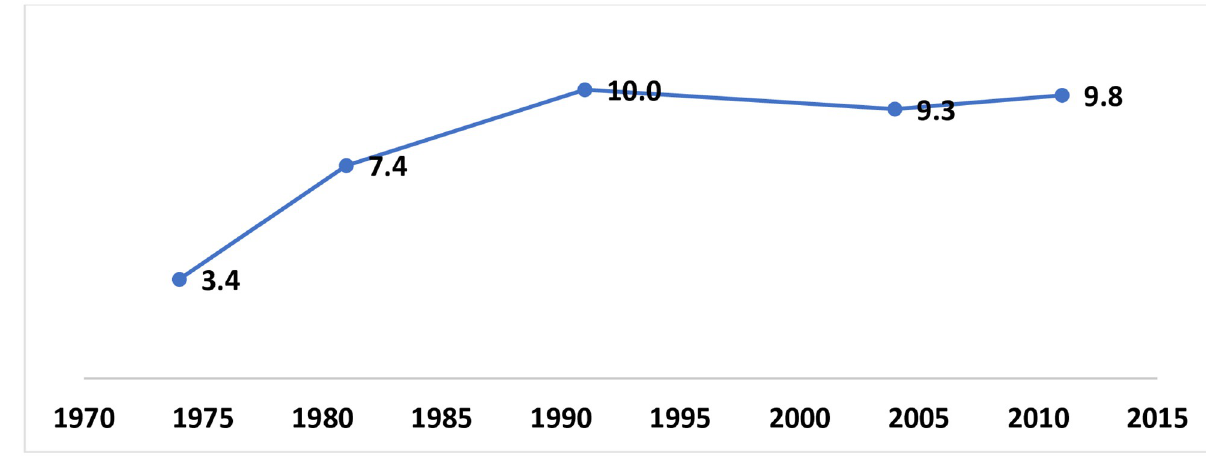
Fig 2. Trends (%) in lifetime internal migration in Bangladesh,